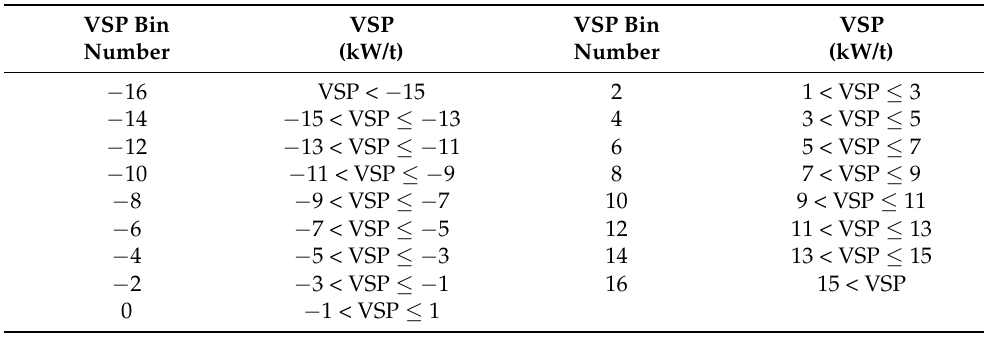
Table 2. Bins of VSP for light-duty